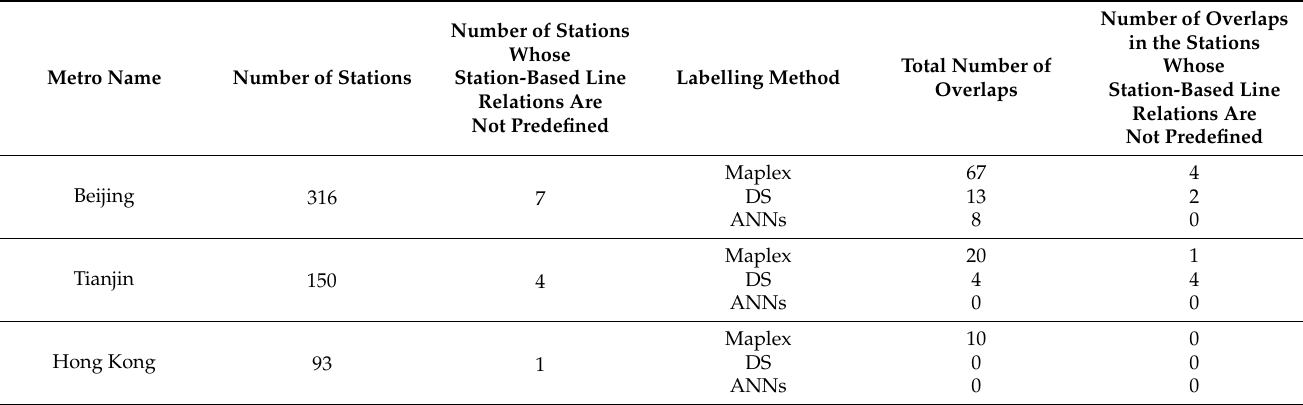
Table 2. Statistical results of name labels placed by three automated labelling methods.